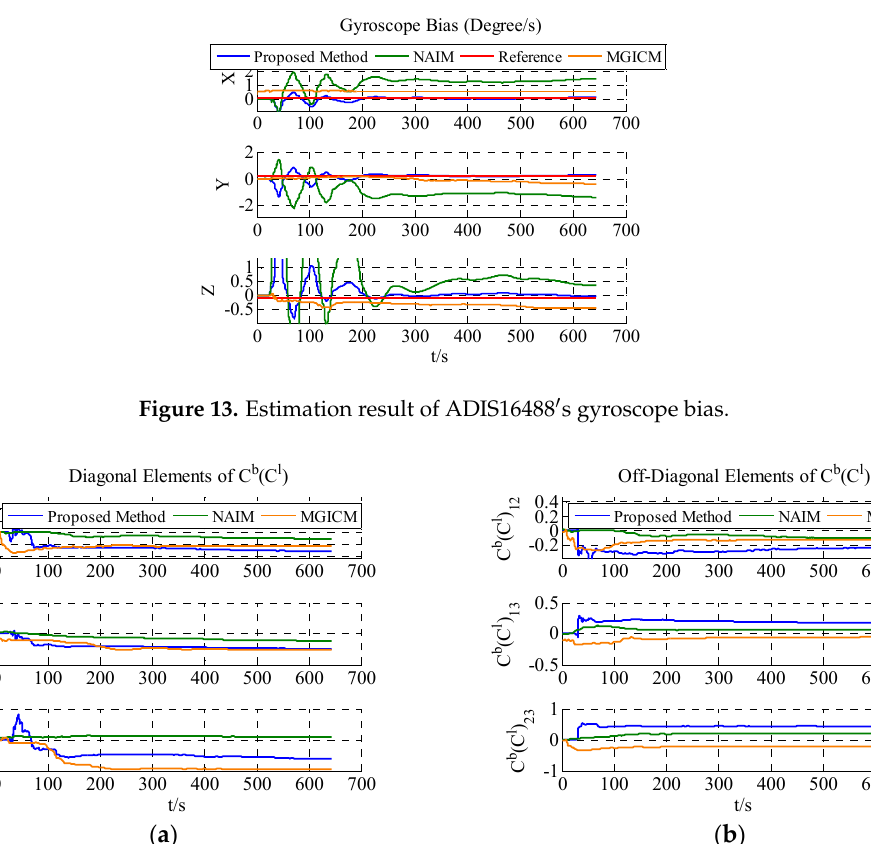
Figure 12. Estimation results of ADIS16488 ′ s magnetometer bias.